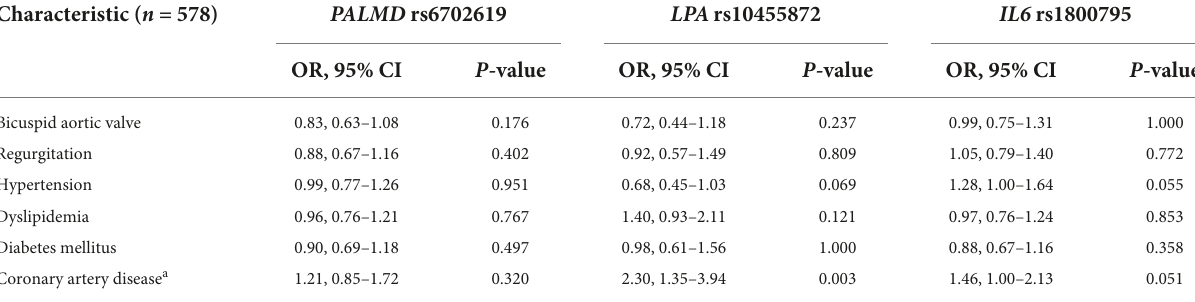
TABLE 3 Association analyses between polymorphisms and several cardiovascular traits.